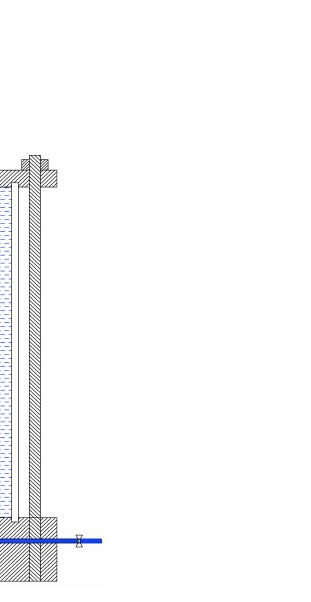
( b ) Figure 14. Modified triaxial test equipment for underwater coal mining cutting resistance testing: ( a ) modified triaxial test equipment, ( b ) testing wedge position. Additionally, the wedge is also loaded by a vertical force by using a steel rod that passes through the top cap of the cell. In the second stage of the test, the rod gets pushed down, at a constant rate, by an electric motor, and the vertical deformation rate is constant so that the wedge force on the sample gradually increases. The force is therefore measured using a strain gauge or a compression ring, and the vertical movement of the wedge is measured by a mechanical or an electronic measuring device. The vertical wedge force on the sample will also gradually increase, but after some time, this reaches a maximum and shows some small additional decreases, somewhat. The maximum of the vertical force indicates that the sample starts to fail.